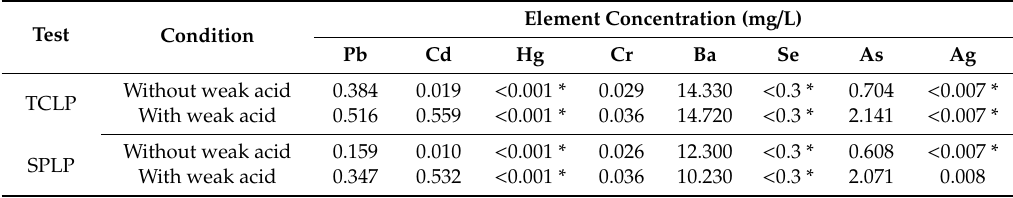
Table 8. Chemical composition for the TCLP and SPLP tests.